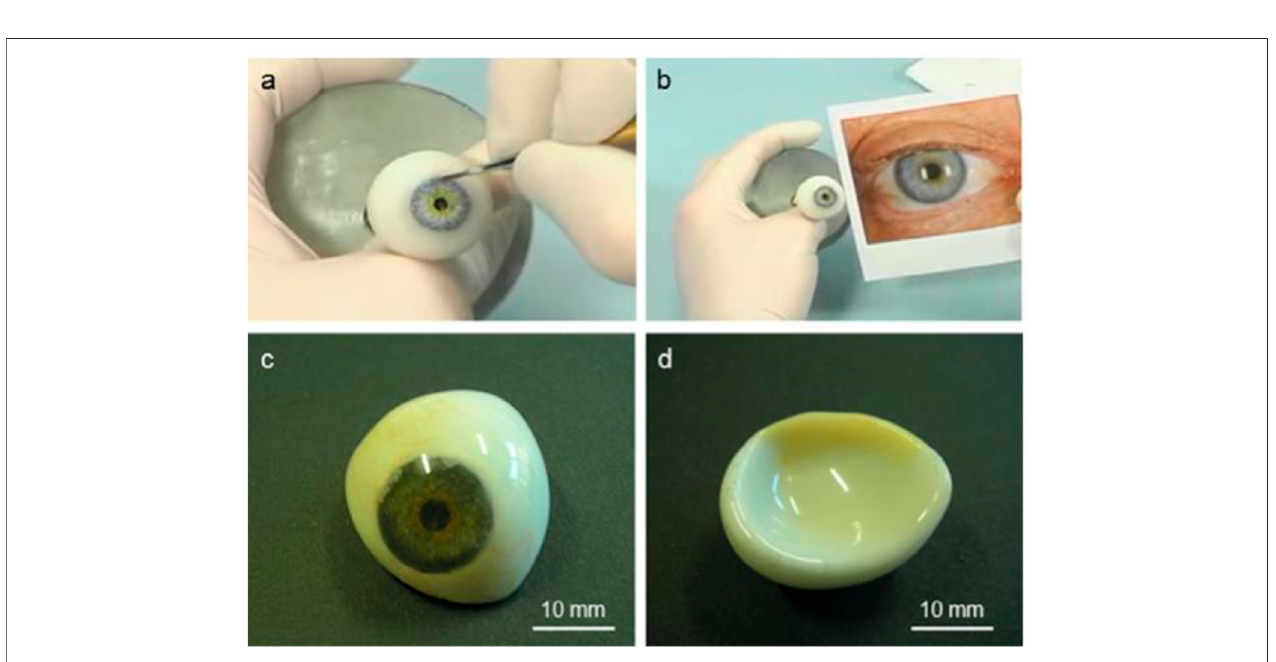
FIGURE 8 | Example PMMA ocular prosthesis: (A) hand coloring of the iris button to match the aesthetic look of the healthy eye (B) , (C) frontal appearance of the fi nished prosthesis (with painted capillary vessels, iris, and pupil) following cleaning for optimum fi t to the architecture of the client, and (D) backside convex surface.